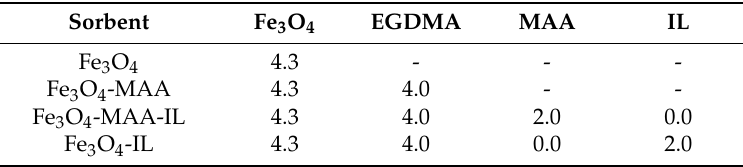
Table 2. Molar ratio for the synthesized sorbents (mmol); EGDMA: ethylene glycol